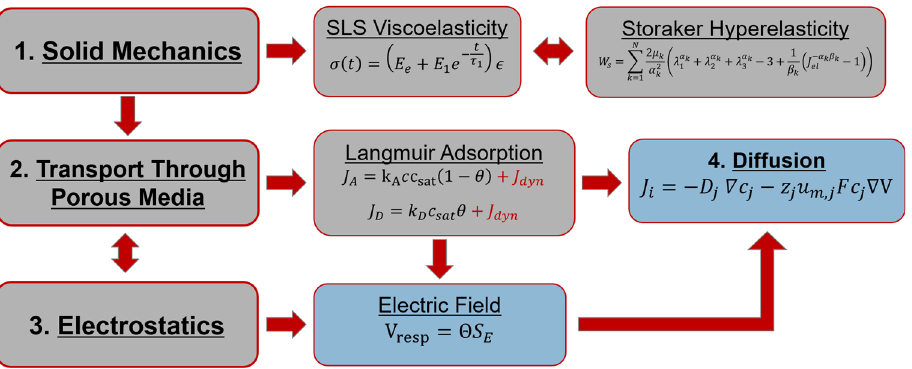
Figure 6. Flow chart of multiphysics model including the three major physics modules included in this study with plasticizer concentration gradient and electric potential response (blue).